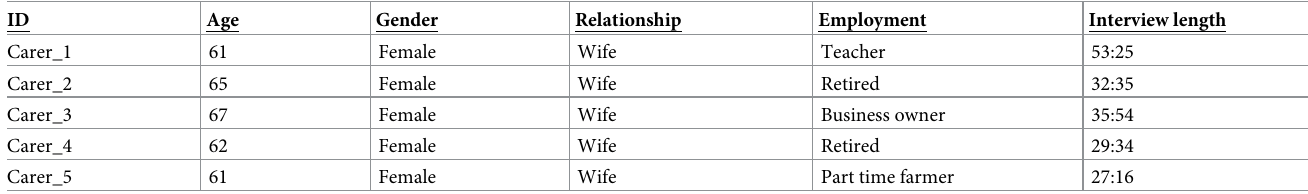
Our findings are outlined through four key components of intervention design, namely (i) engagement must be meaningful, (ii) the point of readiness to intervene (iii) a familiar, but flexible setting is key and (iv) pragmatics of intervention delivery. Fig 1 provides a visual repre- sentation of these four main themes, and associated sub-themes, which each discussed in turn below.